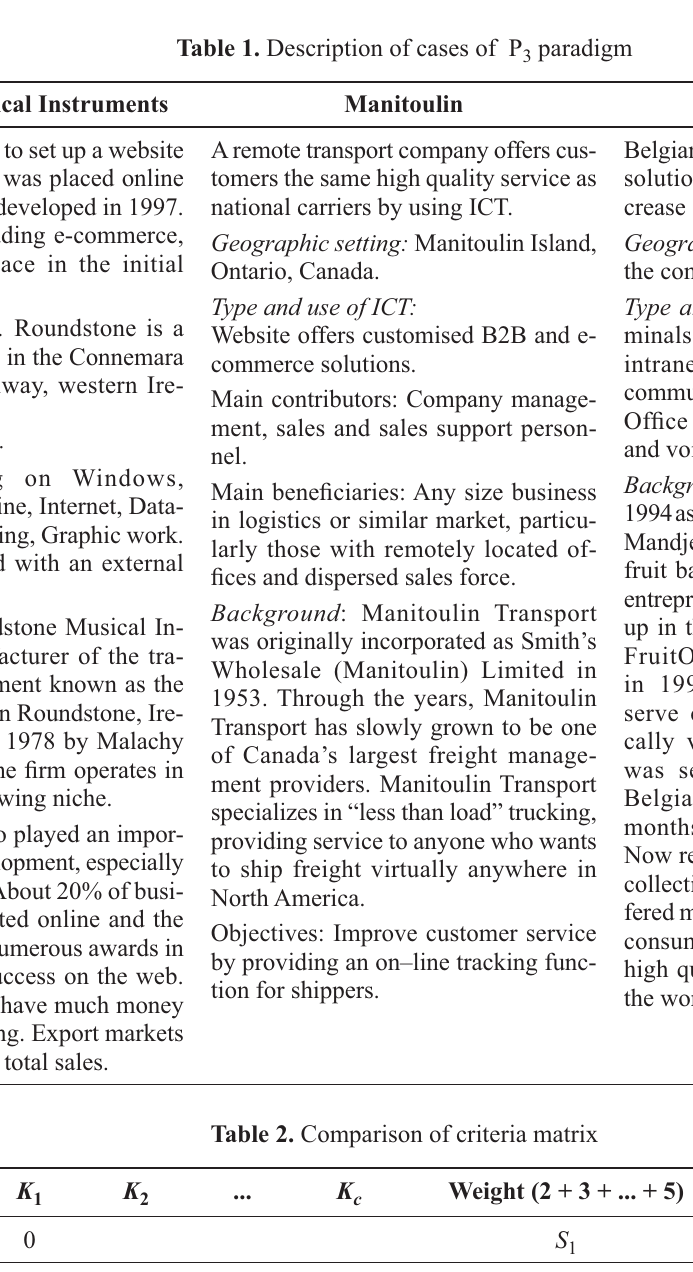
Table 1. Description of cases of P